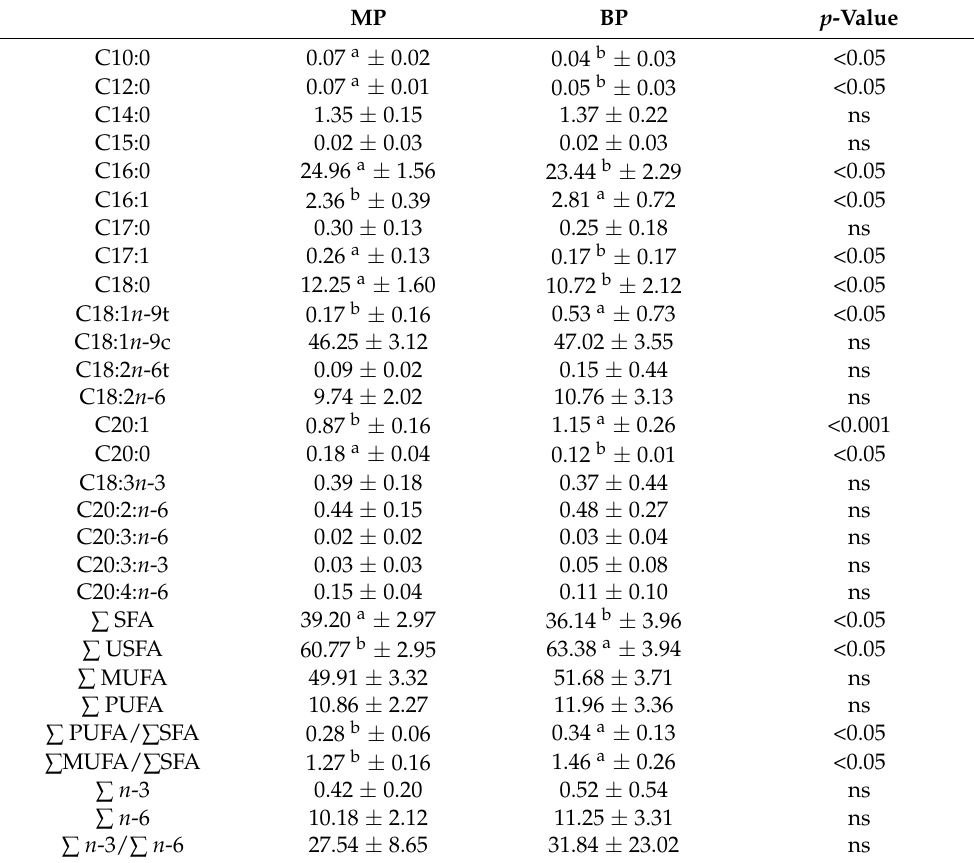
Table 2. Fatty (mass fraction, %) Acids Profile of Slavonska slanina